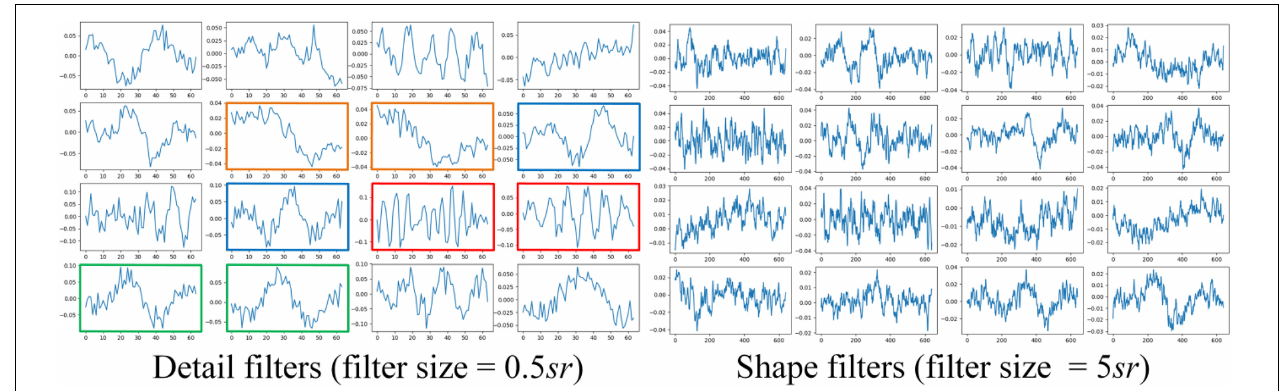
FIGURE 9 | Examples of learned CNN filters in the feature learning parts of the network. Figures in green frames, learned filters that match characteristic waves during eye movements. Figures in red frames, filters that match spindle waves. Figures in blue frames, filters that match k-complex. Figures in yellow frames: filters that match slow